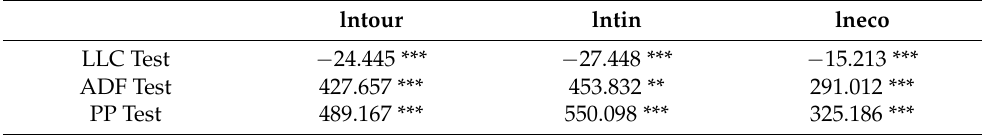
Table 4. Unit root test results.